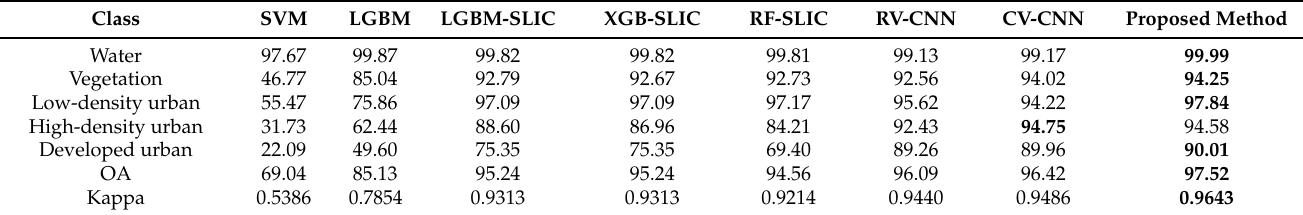
Table 3. Accuracy results of San Francisco